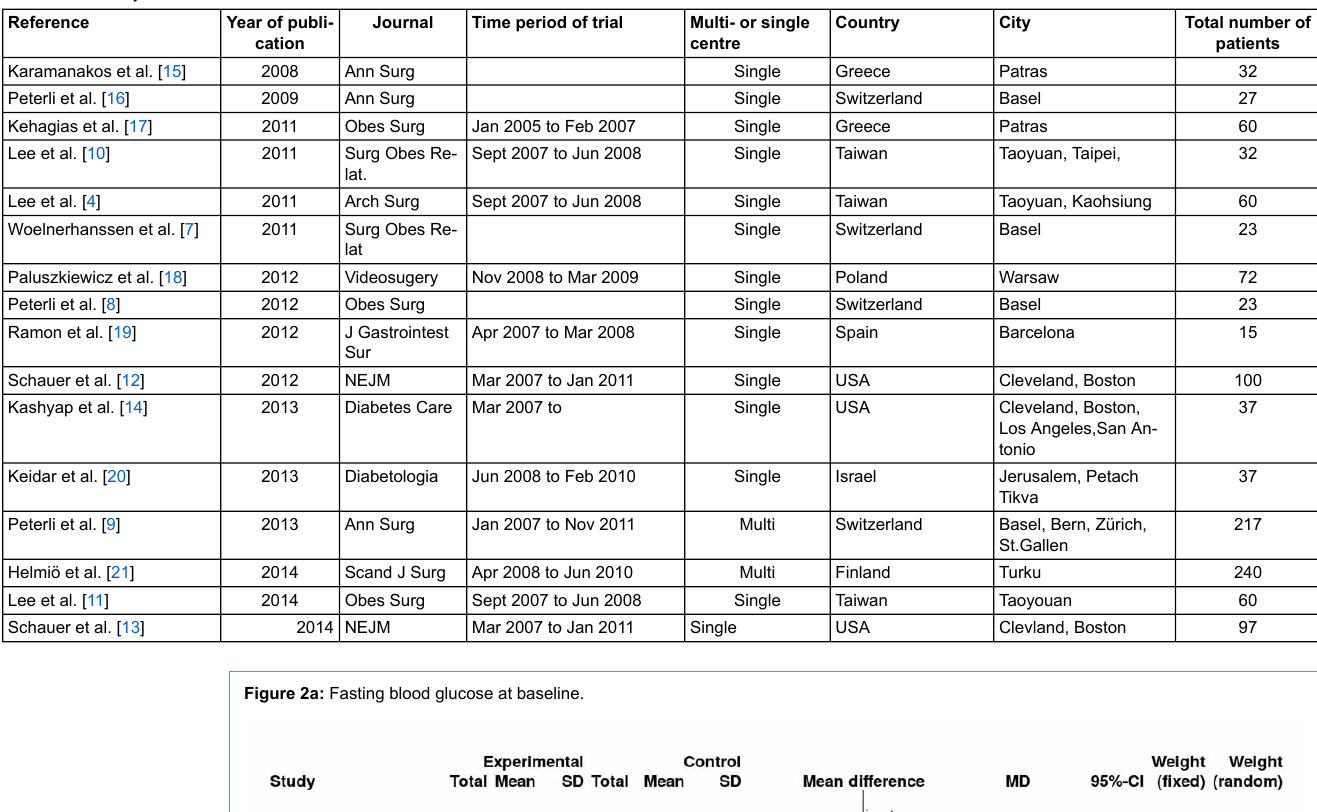
Table 1: Summary of the randomised controlled trials included. Reference